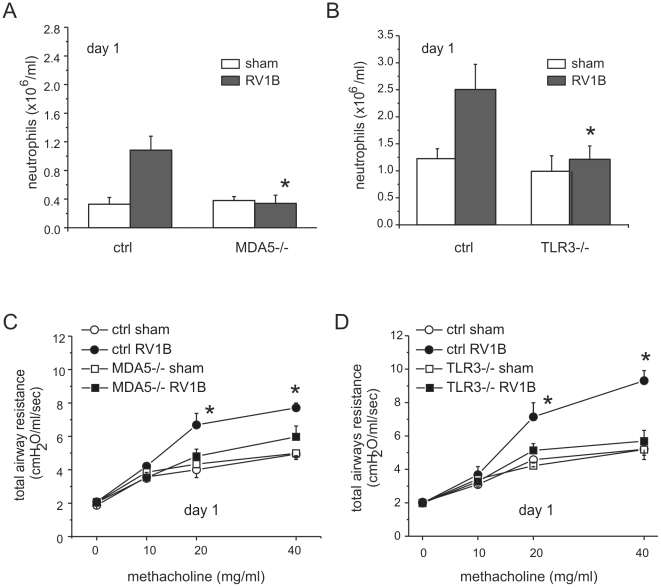
Airway inflammation and responsiveness in RV1B-infected MDA5−/− and TLR3−/− mice.MDA5−/−, TLR3−/−, and their control mice were infected with RV1B. Twenty-four h after infection, RV1B-induced neutrophil infiltration was determined in MDA5−/− mice (A) and TLR3−/− mice (B) along with their respective controls. Data represent mean±SEM for 3–7 mice, *p<0.05, one-way ANOVA). Total respiratory system resistance of MDA5−/− (C) and TLR3−/− (D) mice were determined by plethysmography. Data represent mean±SEM for 3–7 mice (*p<0.05, two-way ANOVA).